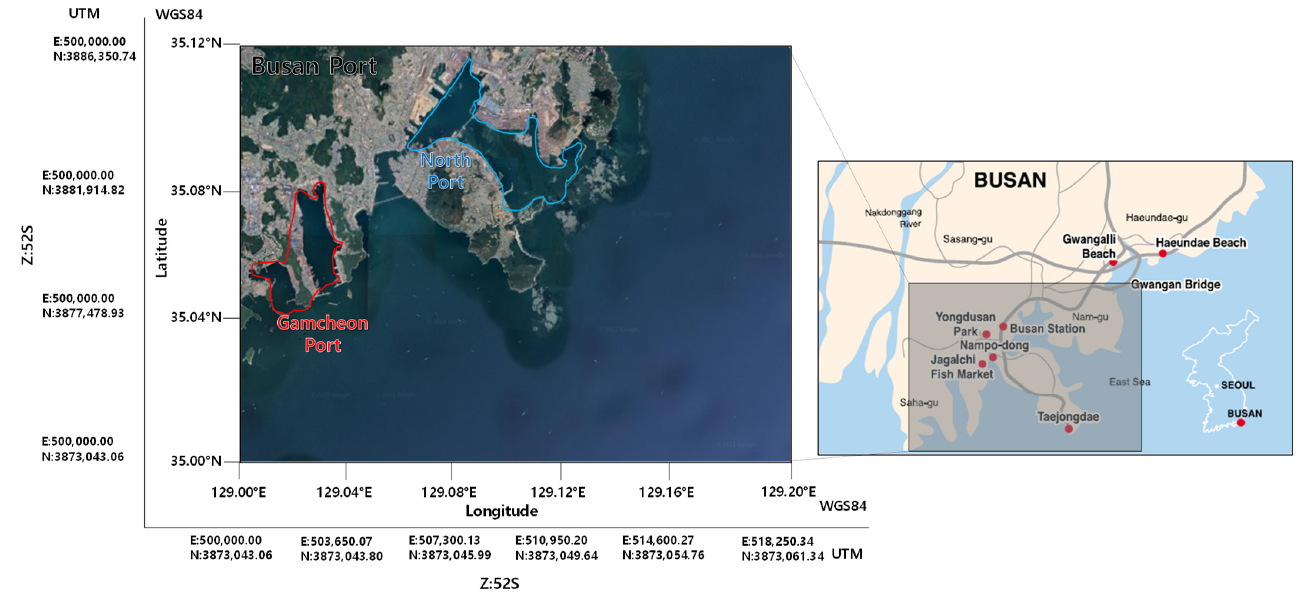
Figure 2. Analysis domain in BP [8].